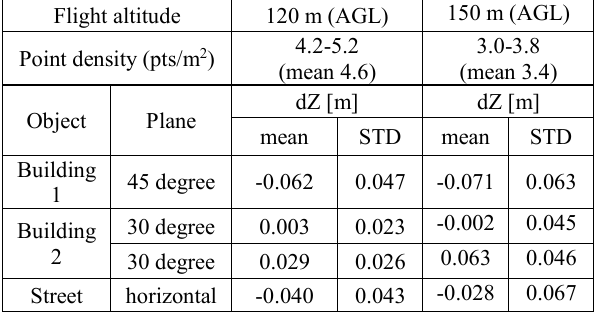
Table 4. The results of ULS data processing: statistics from RiProcess before and after orientation